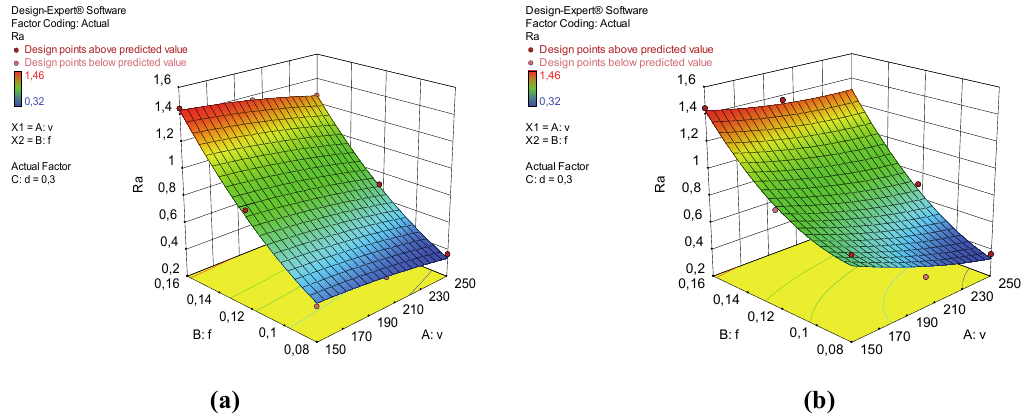
Fig. 5 . Effect of cutting speed and feed rate on surface roughness Ra